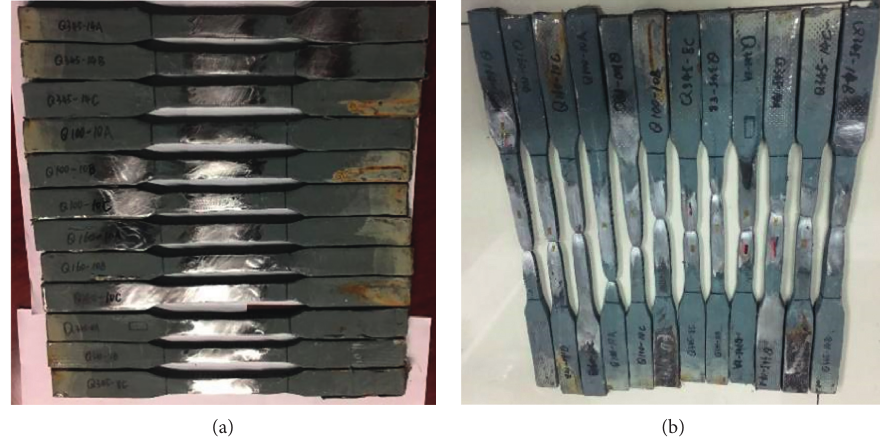
Figure 6: Photographs of the material specimens. (a) Before stretching. (b) After fracture. Table 2: Test results of steel material